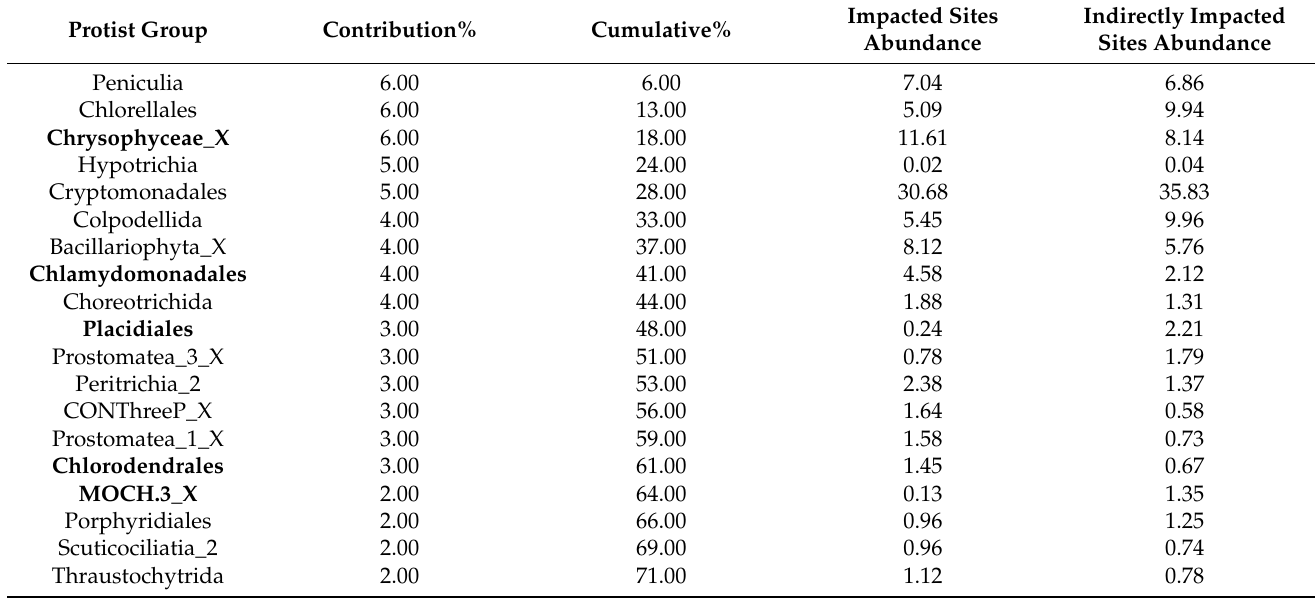
Figure 6. Redundancy analysis ordination, within two dimensions of protists communities within sampling sites, during 5–10 October 2019, along the New River, Belize. Legend shows trophic state and impact status. Significant taxonomic drivers of variation are shown by blue arrows. Significant environmental drivers are shown by red arrows. Table 1. Similarity percentage analysis to identify protist orders that best differentiated impacted and indirectly impacted sites during 5–10 October 2019, along the New River, Belize. Contribution percentage for each group and cumulative percentage (up to 70%) are shown. Mean relative abun- dance of protist groups is shown for impacted and indirectly impacted sites. Groups with significant contributions to dissimilarities are in